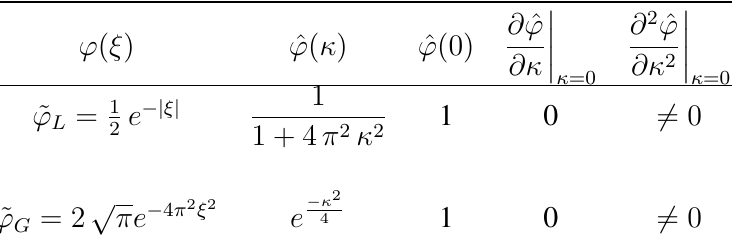
= 1 / 2 e −| ξ | ; ( b ) Fourier transform L